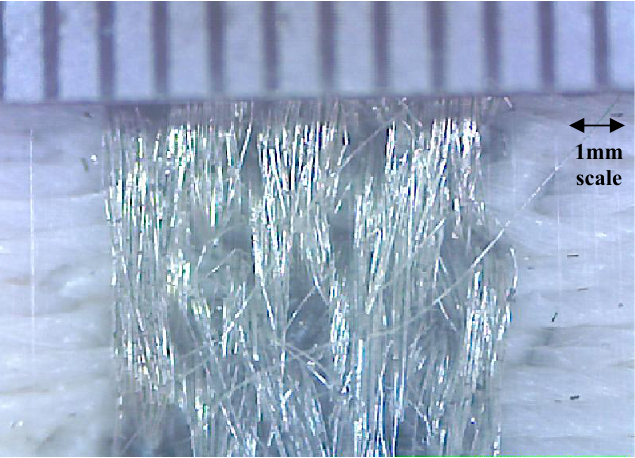
Figure 7. Embroidered patch antenna magnified to observe the air gap between the conductive